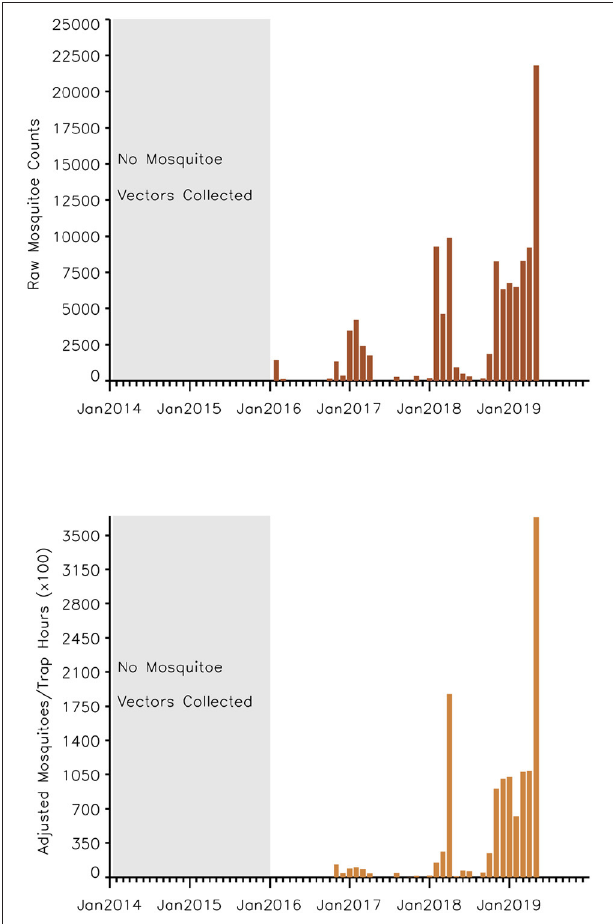
FIGURE 7 | Time series of aggregate mosquito vector counts (of various floodwater Aedes spp . and Culex spp. ) for the study period September 2014–2019 ( top ) raw mosquito vector counts ( bottom ), adjusted mosquito vector counts accounting for trap effort during the study period. The number of vectors collected shows an increasing trend over time in concert in the increase in rainfall improving habitat conditions. Taking into consideration the trapping effort, 2014–2015 and 2015–2016 seasons had no vectors collected during this period of severe drought